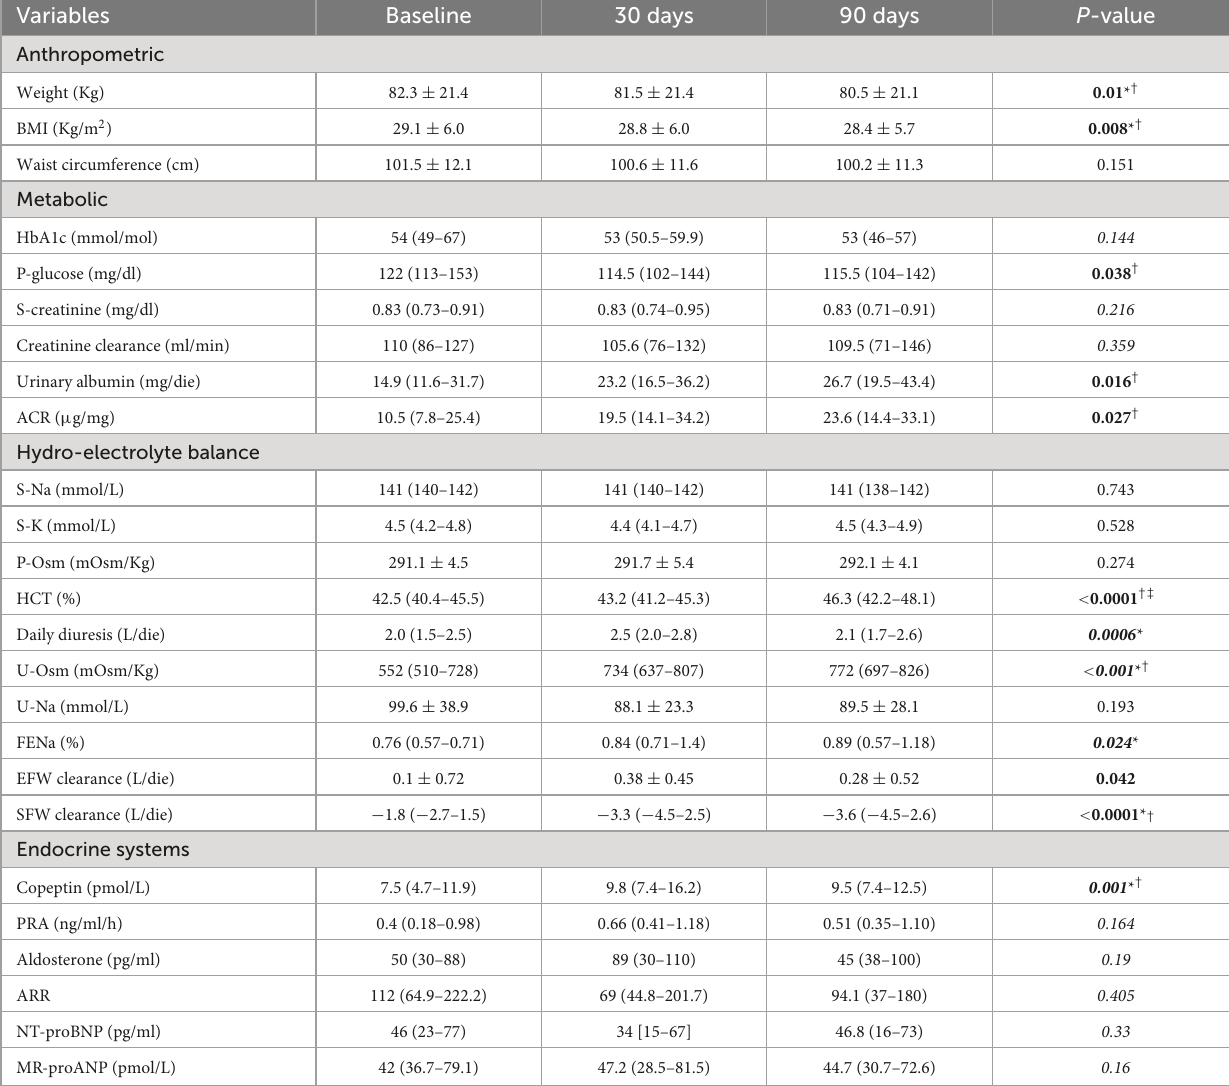
TABLE 2 Changes in anthropometric, metabolic, hydro-electrolyte, and hormonal variables during the study protocol.